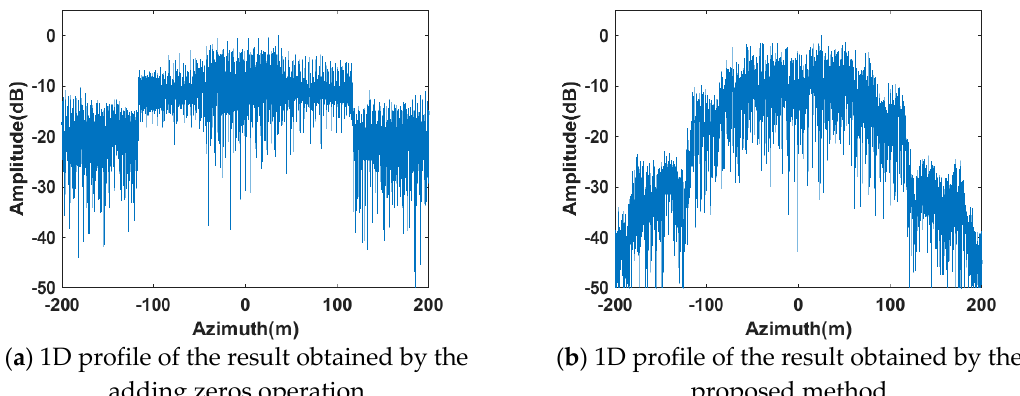
Figure 18. 1D profiles of results at -150 m in range direction: ( a ) 1D profile of the result obtained by the adding zeros operation; and ( b ) 1D profile of the result obtained by the proposed method.